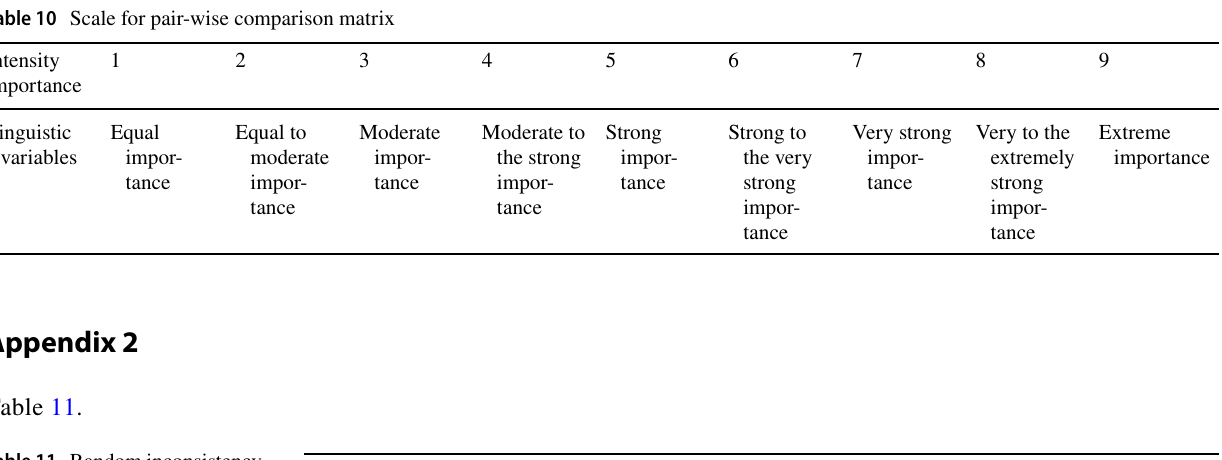
Table 11 Random inconsistency values (Saaty